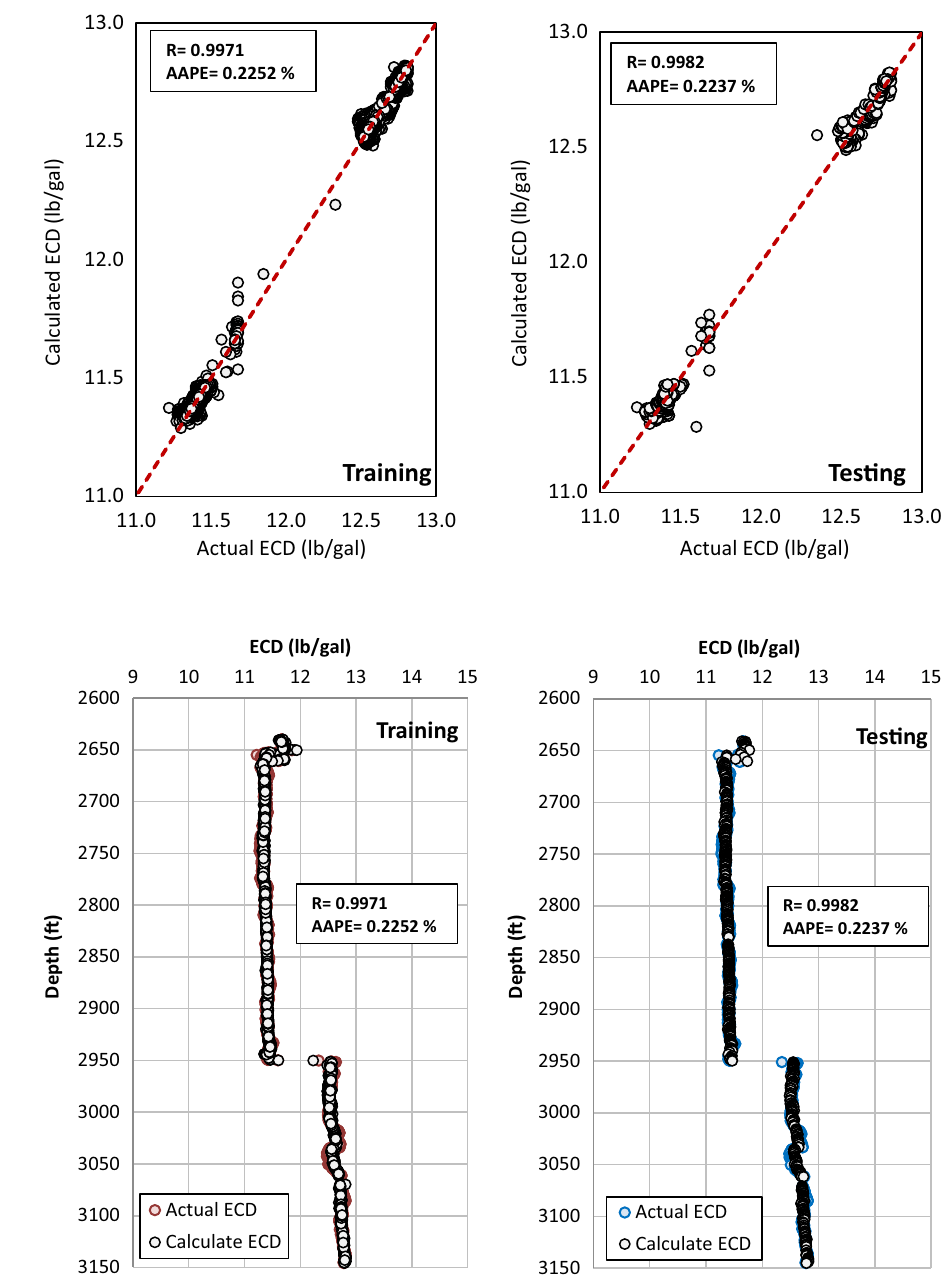
Fig. 7 ECD profile of both ANN model training and testing compared with actual ECD